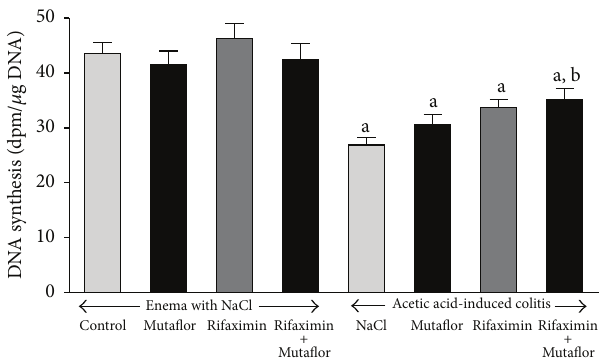
Figure 4: Influence of E. coli Nissle 1917 (Mutaflor) and rifaximin on DNA synthesis in colonic mucosa in rats without or with acetic acid- induced colitis. Mean value ± SEM. 𝑁 = 8 animals in each experimental group. a 𝑃 < 0.05 compared to control saline-treated rats without induction of colitis; b 𝑃 < 0.05 compared to colitis + NaCl.